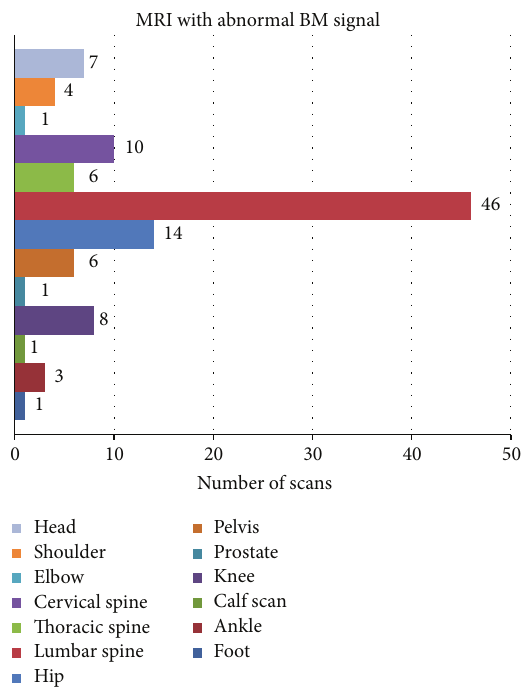
Figure 2: Number of abnormal MRI scans by anatomic location.